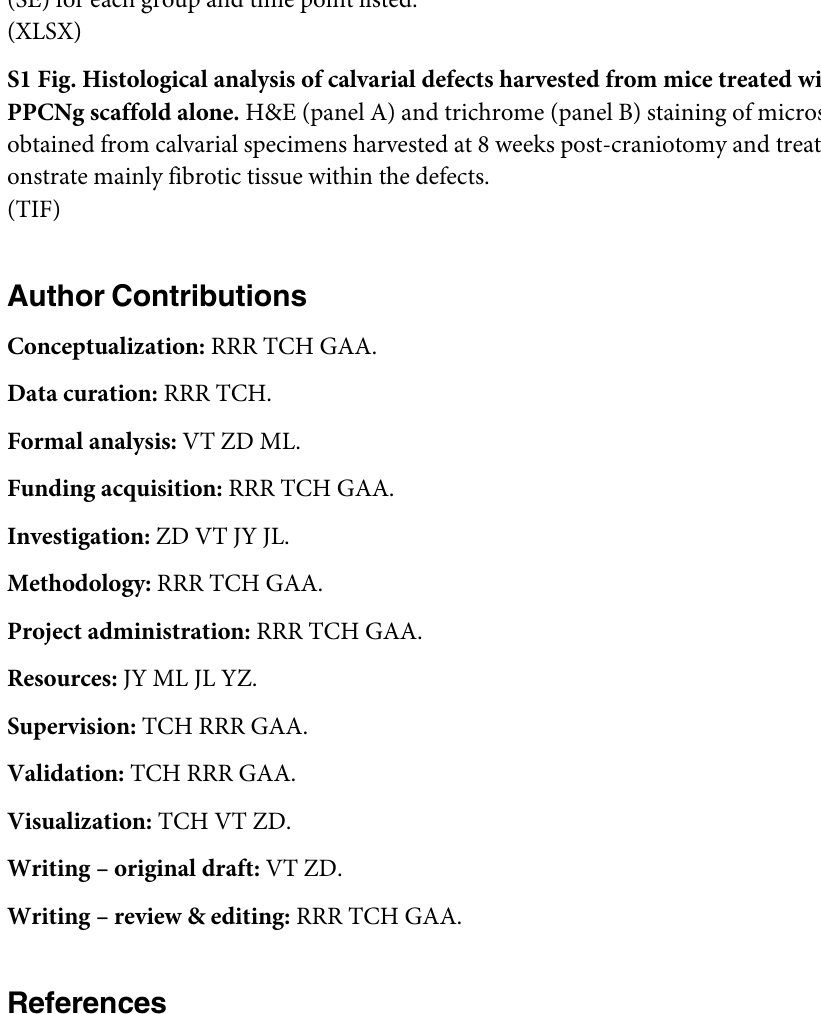
S2 Table. Raw data of defect volume size (mm3) for PPCN-g alone, Ad-GFP and Ad-BMP9 treated groups. Averages (AVG), standard deviation (SD) and standard error of the mean (SE) for each group and time point listed. (XLSX) S1 Fig. Histological analysis of calvarial defects harvested from mice treated with the PPCNg scaffold alone. H&E (panel A) and trichrome (panel B) staining of microsections obtained from calvarial specimens harvested at 8 weeks post-craniotomy and treatment dem- onstrate mainly fibrotic tissue within the defects.